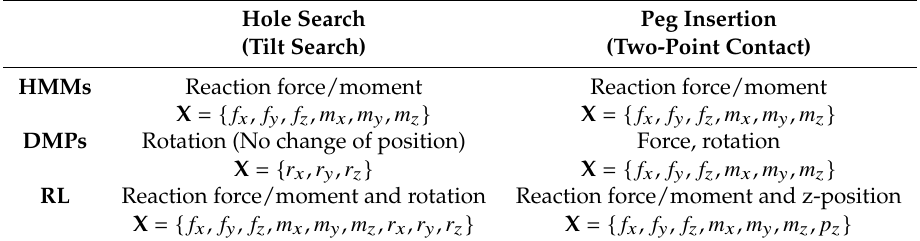
Table 1. States for HMMs, DMPs, and reward for RL for “hole search” and “peg insertion” motor